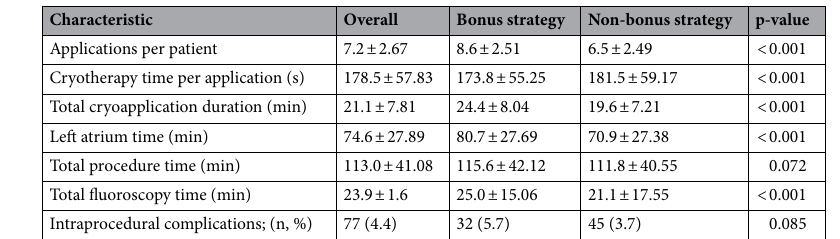
Table 3. Procedural characteristics by cryoablation strategy. Quantitative data are expressed as (mean ± SD).